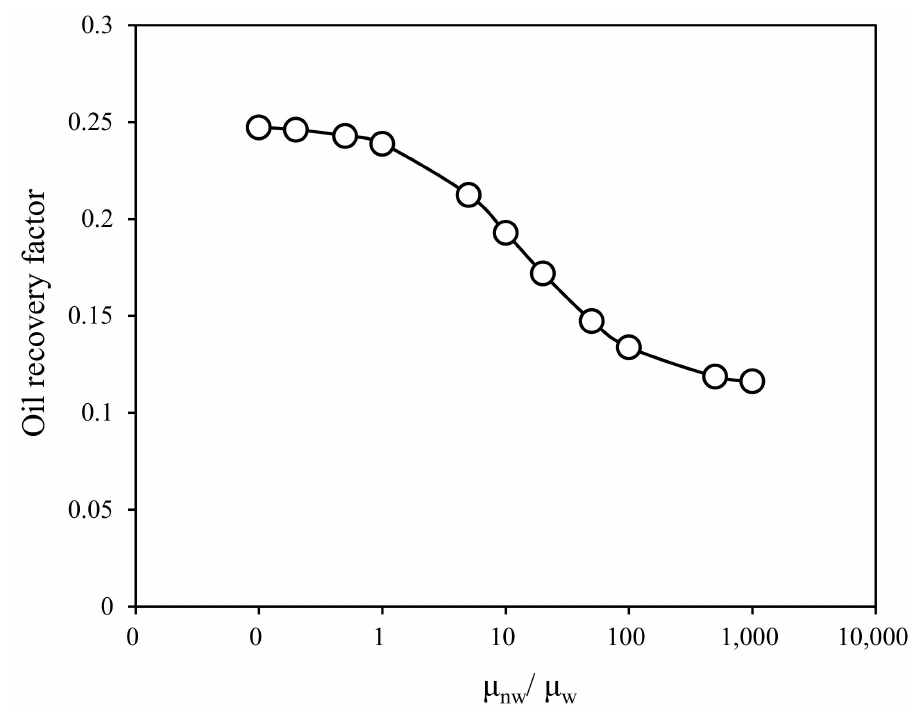
Figure 14. Diagram of the viscosity ratio of the imbibition amount of three interacting